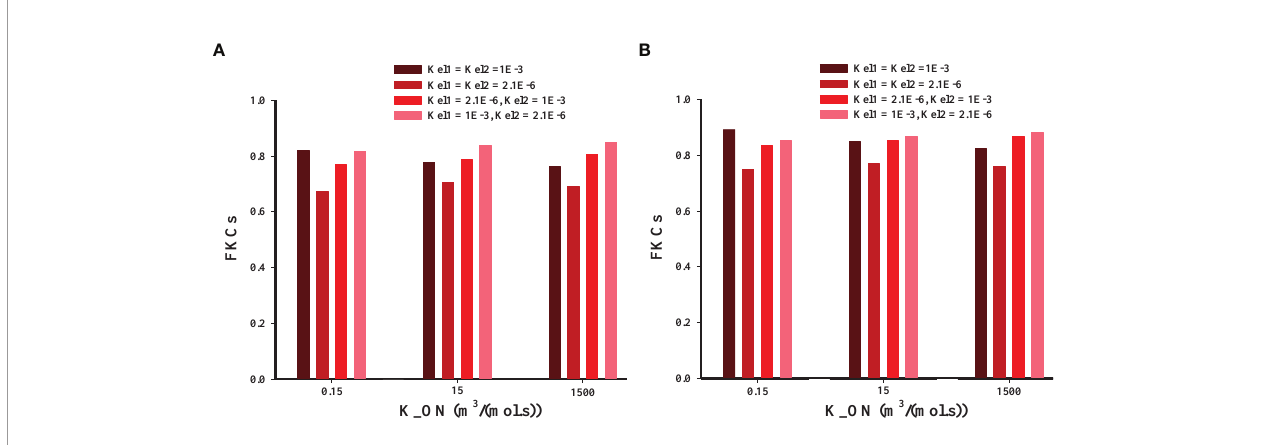
FIGURE 9 | Comparison of treatment ef fi cacy of two multi-stage delivery scenarios for different values of K ON , K el1 , and K el2 . (A) NP1=100nm and NP2=10nm, (B) NP1=20nm and